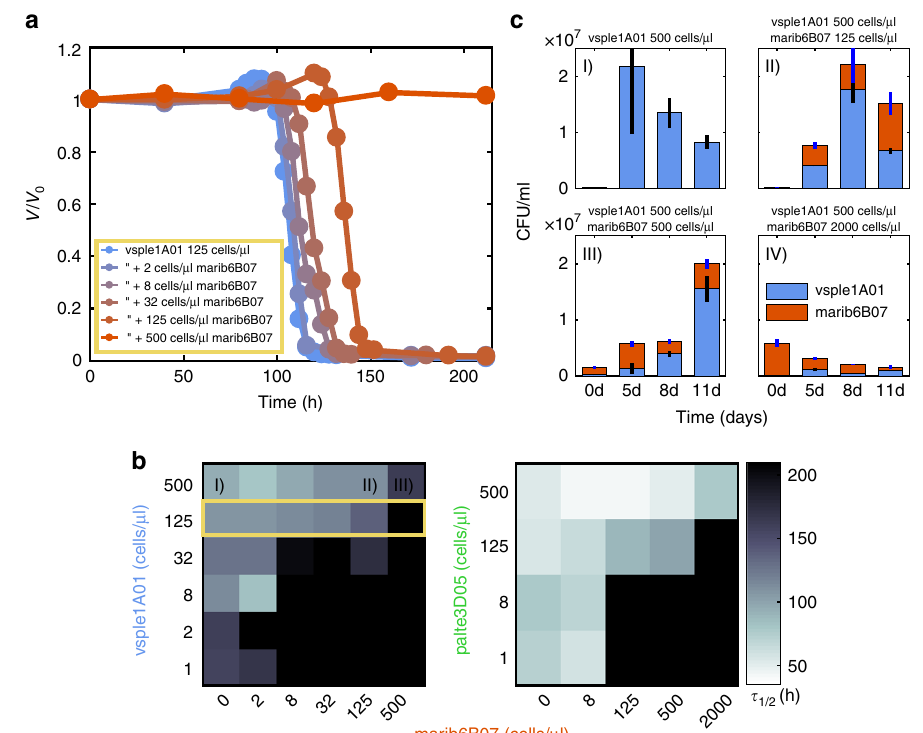
Fig. 3 Secondary consumers inhibit degradation. a Particle degradation curves with different marib6b07 concentrations. At increasing concentrations of the secondary consumer the particle half-life increases disproportionally beyond the 220h time limit. b Heat maps depict τ 1/2 as a function of different primary degrader and secondary consumer inoculum concentrations and show that particle half-lives depend on the relative concentrations of primary degrader and secondary consumer cells. Color scale is the same for both heat maps. The highlighted row of the heat map corresponds to the degradation curves in a . For all degradation curves used for the heat maps see Supplementary Figs. 7 – 8. c CFUs of vsple1A01 and marib6B07 during coculture on chitin particles, showing that marib6B07 acts as a parasite reducing the yield of vsple1A01. (I) vsple1A01 in monoculture. Particle degradation observed at ~5 days. (II, III) Cocultures, particle degradation observed at ~8 and ~11 d, respectively. (IV) Coculture: no degradation observed (the error bars represent 1 standard deviation for n = 3 replicates). Decrease in CFU counts is due to loss of viability after